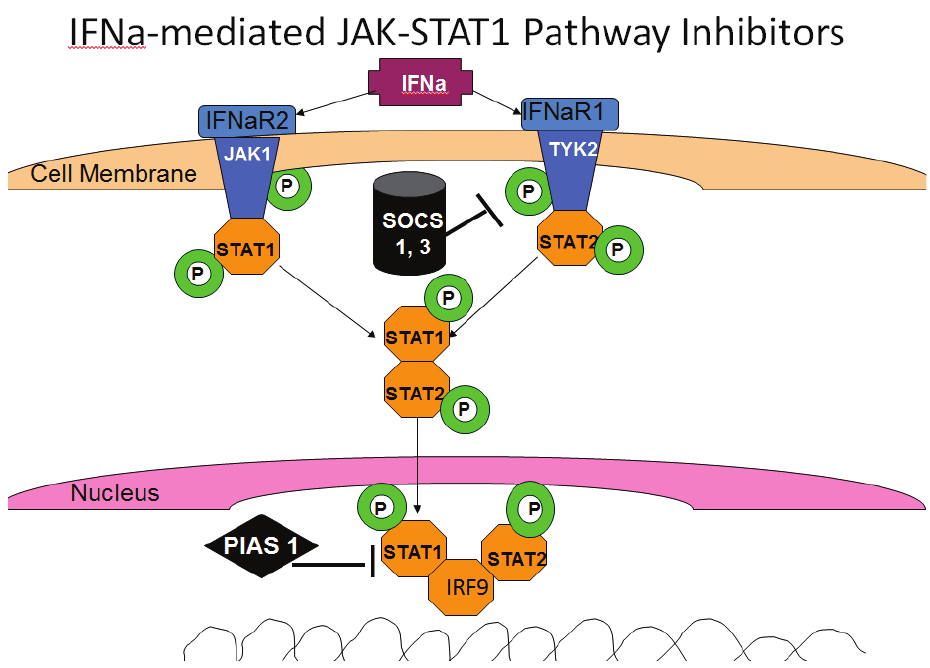
Figure 3. IFN-induced signaling through the JAK-STAT